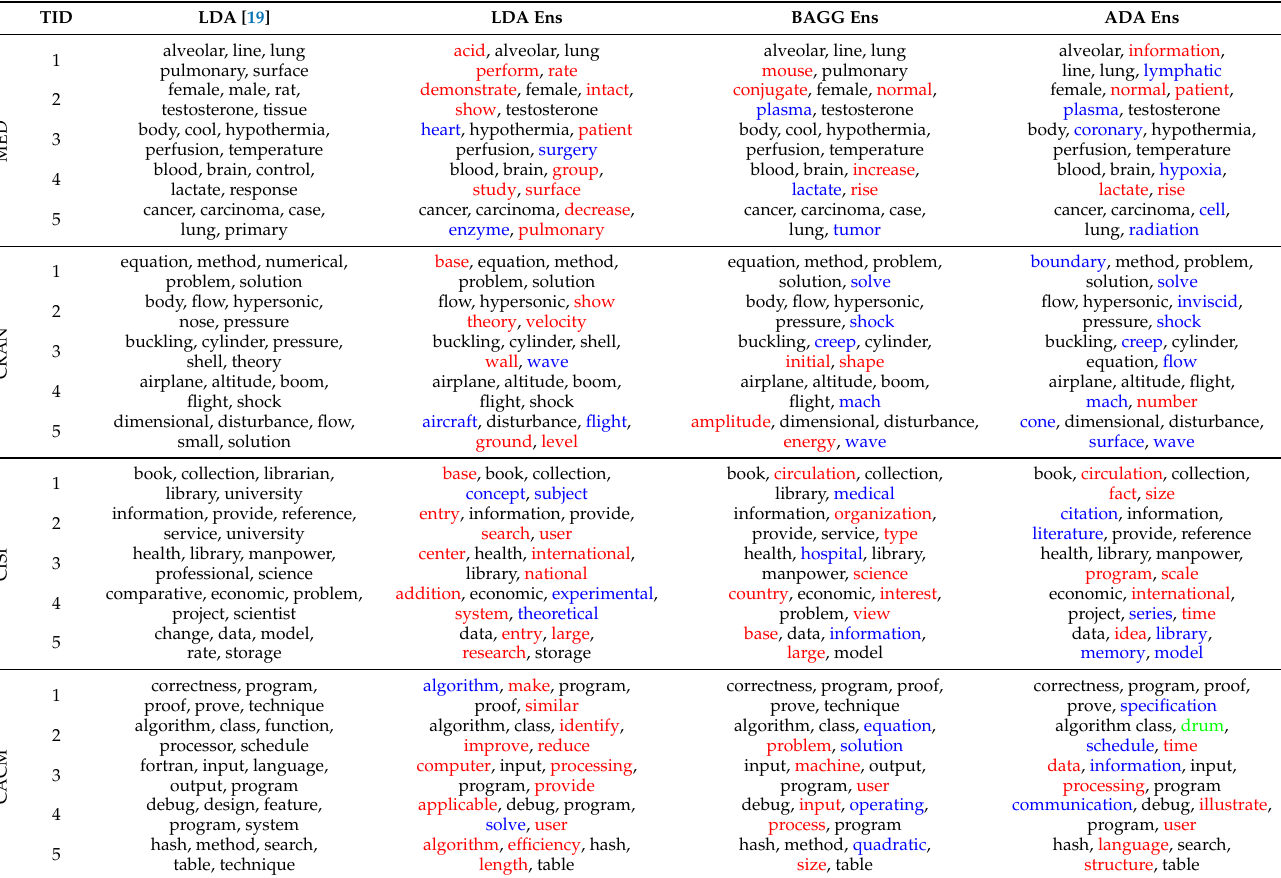
Table 6. Top-5 words per topic for the ensemble strategies proposed. The most generic words are indicated in red, while the most specific ones are displayed in blue. Off-topic words are displayed in green